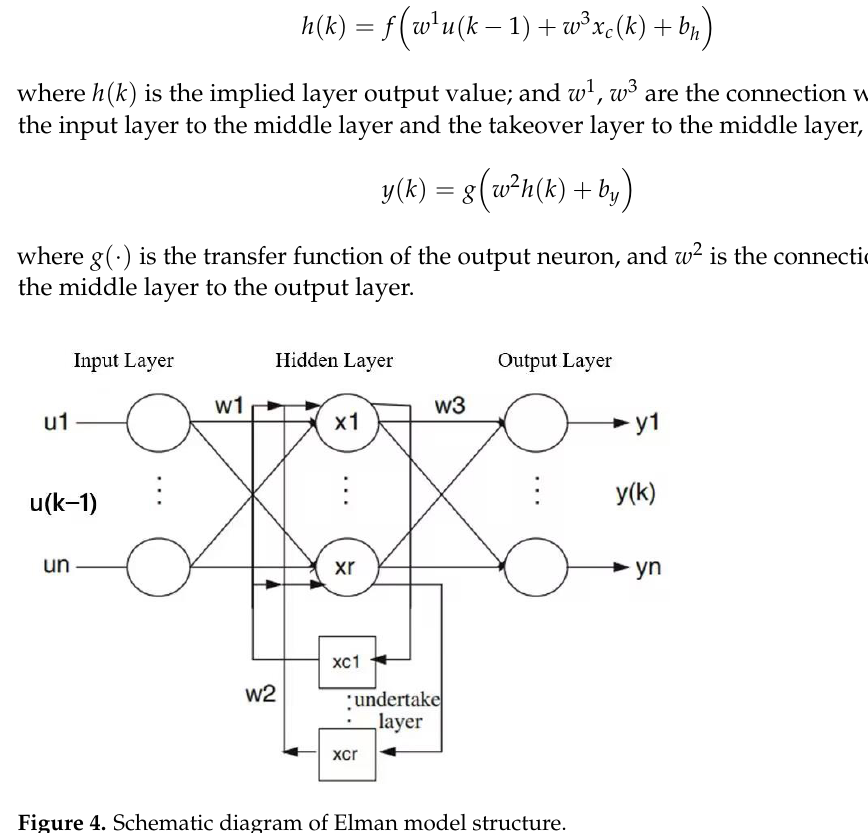
( b ) Figure 5. Principle of the quantile mapping method. ( a ) Cumulative distribution function. ( b ) Probability density function. 3.2. Comparative Experimental Setup 3.2.1. Experimental Setup